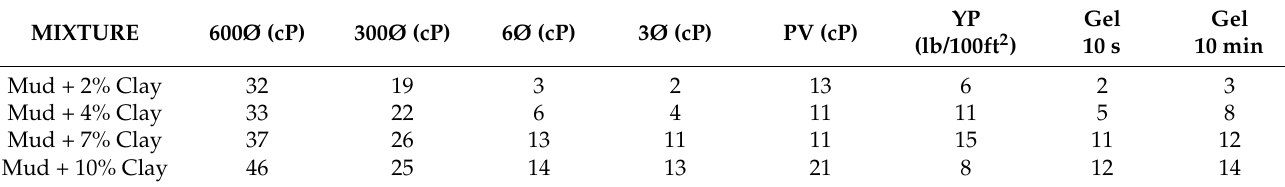
Figure 6. Trend correlation between default mud and clay-concentrated mud. Table 3. Rheological properties for muds with different concentrations of clay.